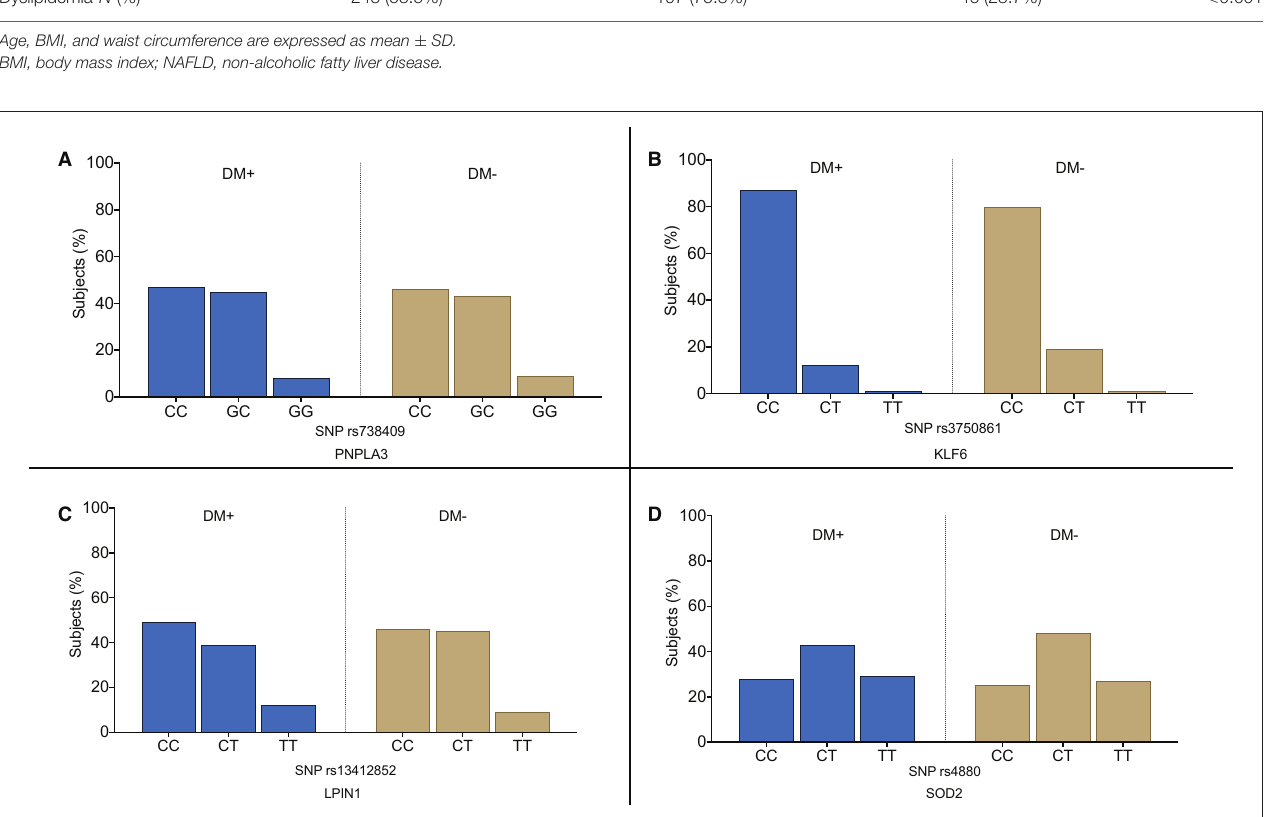
different genotypes in the serum total cholesterol and HDL levels, whereas the patients with the risk allele G showed a lower mean value of serum triglycerides (172.5 mg/dl for CC genotype, 121 mg/dl for CG genotype, and 117 mg/dl for GG genotype; CC vs. CG p < 0.001; CC vs. GG p < 0.001). Table 3 shows no differences that were found